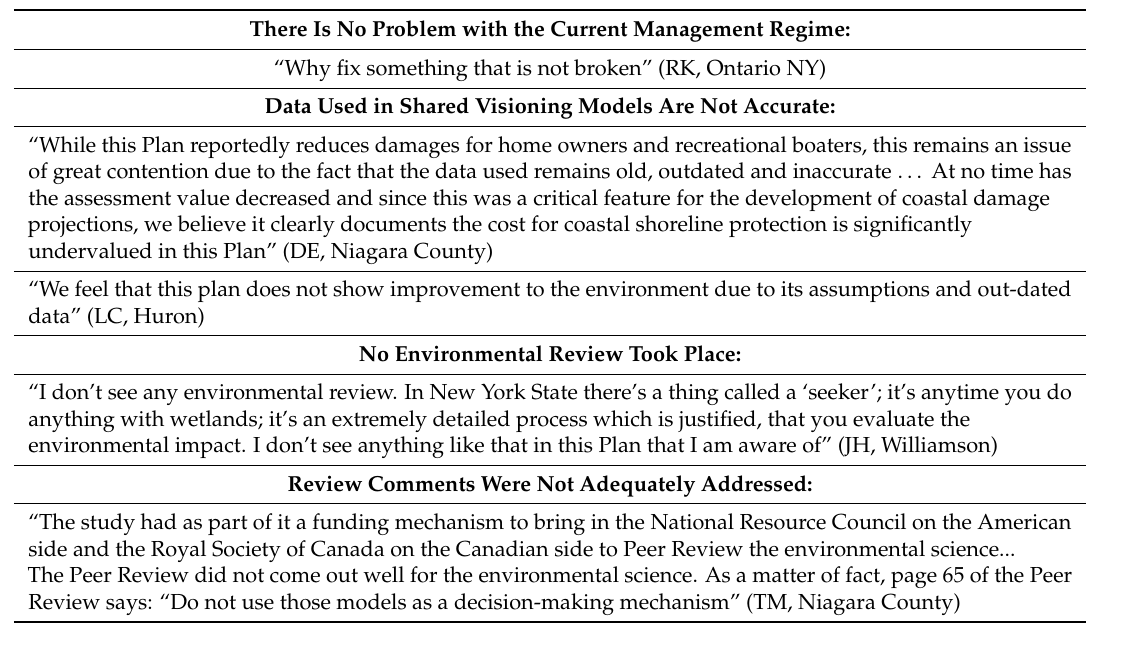
Table 5. Complaints of the Opposed South Shore